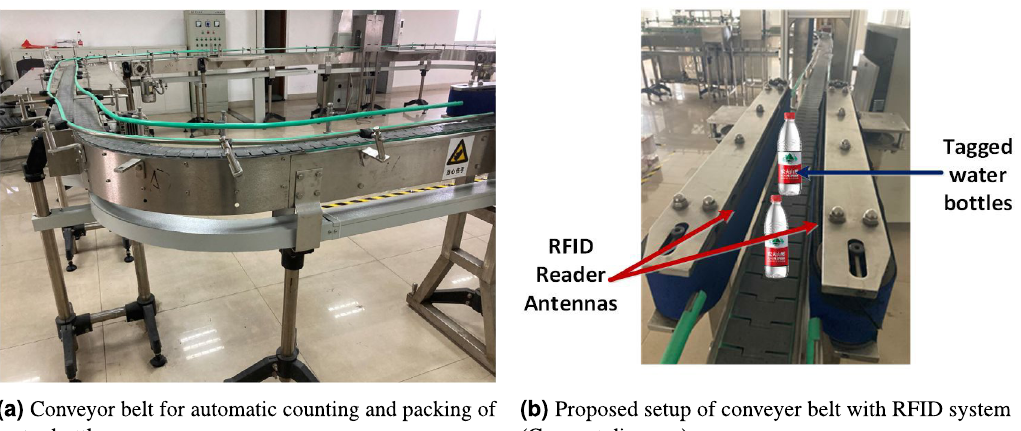
Figure 15. Conveyor belt based commercial application using proposed tag based system.